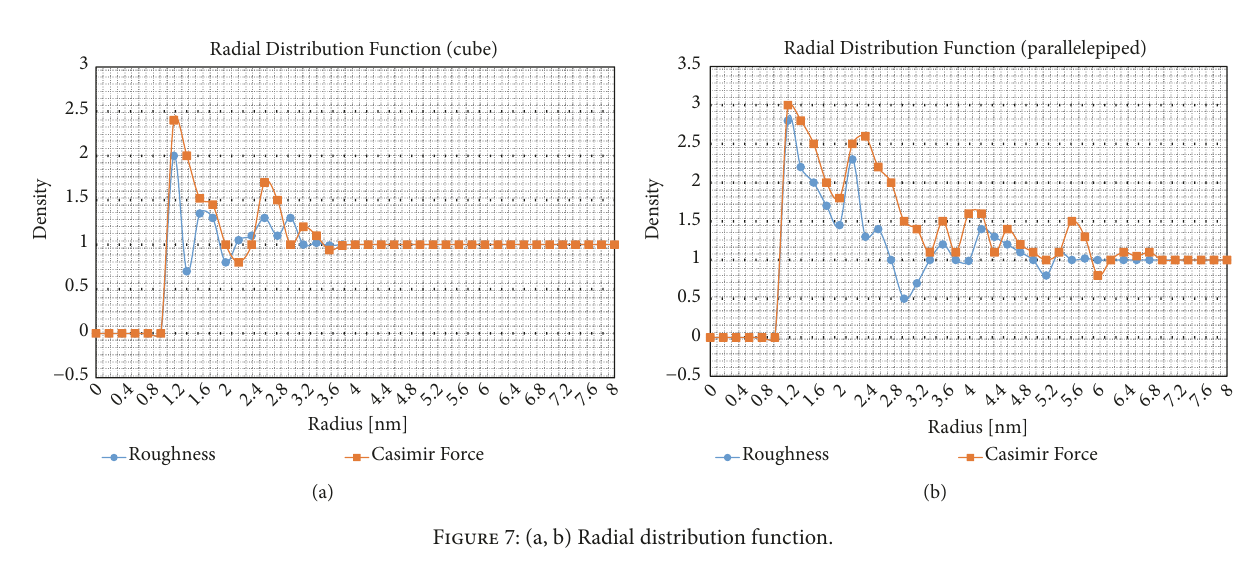
Figure 7: (a, b) Radial distribution